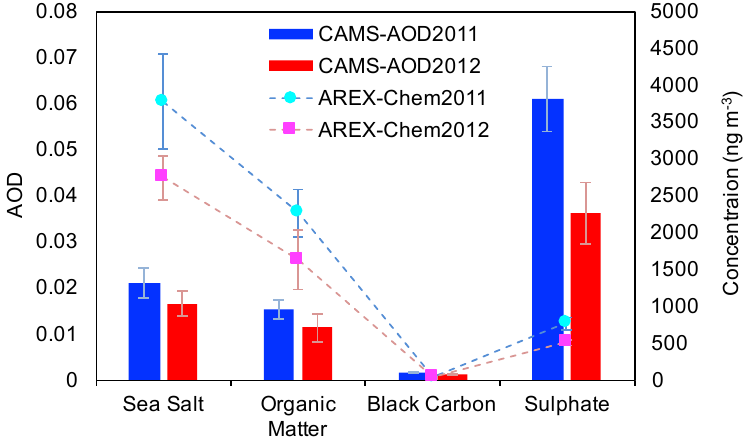
Figure 9. CAMS AOD and AREX2011–2012 chemical concentrations for sea salt, OM, EC, and sulfates.